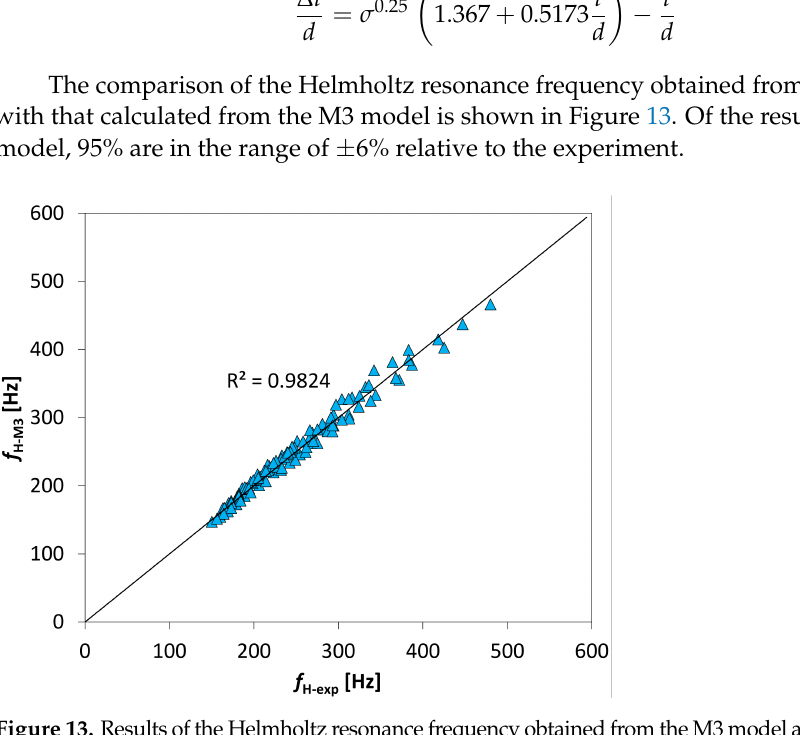
Figure 13. Results of the Helmholtz resonance frequency obtained from the M3 model and the